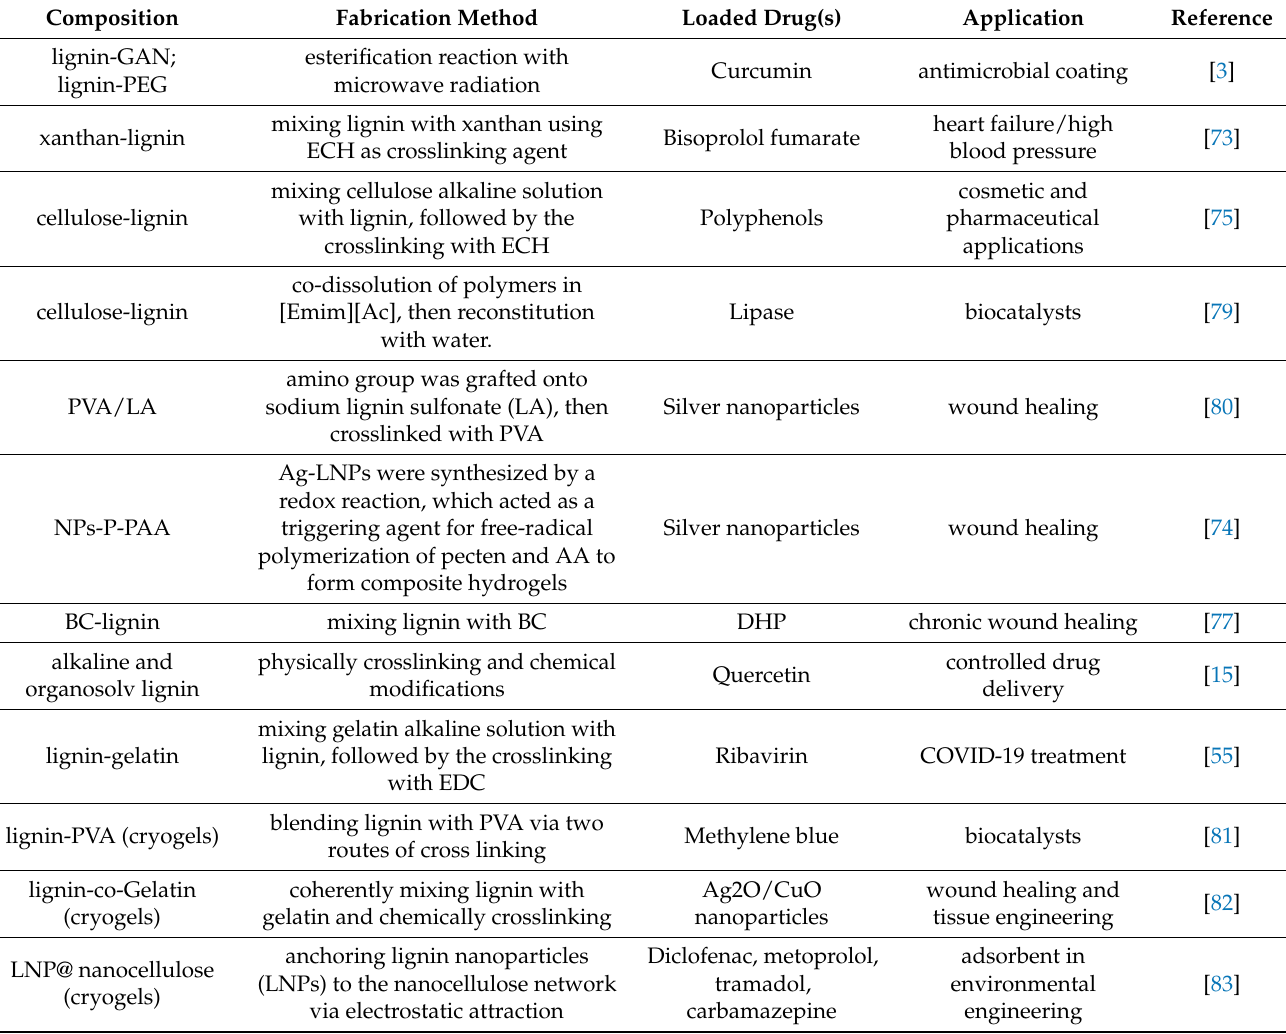
Table 2. Lignin-based hydrogels and cryogels applied for delivery of various bioactive